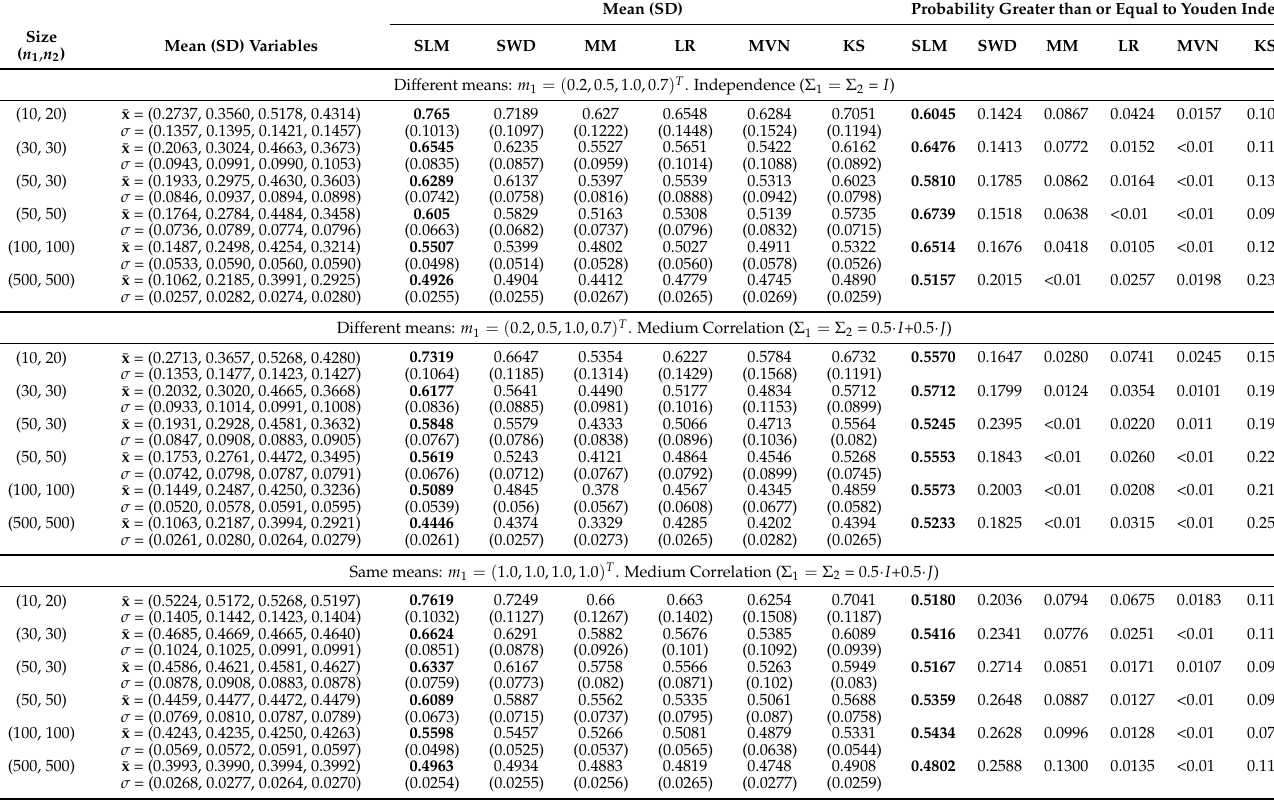
Table 10. Non-normal distributions: Log-normal